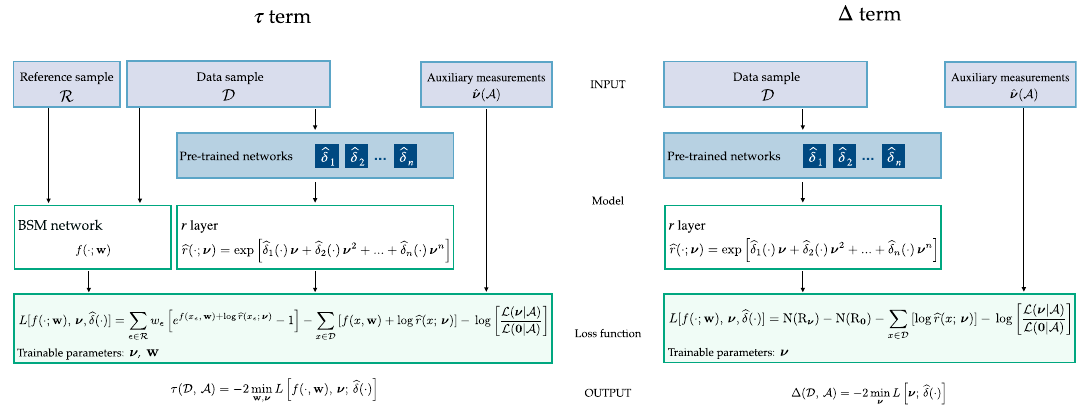
Fig. 4 Schematic representation of the TensorFlow implementation of our algorithm (cid:7) δ As described in Sect. 2.4, computing τ requires the simul- optimized. Indeed, the networks have been trained at a pre- taneous optimization of the parameters w of the neural net- vious stage of the implementation, as described in Sect. work model f ( x ; w ) (dubbed “BSM network” in the figure) and of the nuisance parameters ν . The loss function is the one of Eq. (25). It depends on ν through the distribution ratio r , or more precisely through its estimate (cid:7) r ( x ; ν ) as in Eq. (16). The estimated (cid:7) r ratio is implemented as a TensorFlow “ λ -layer” (denoted as “ r layer” in the figure) that takes as input the (cid:7) δ output of the networks and builds the required polynomial (cid:7) δ function of ν . Notice that the parameters of the networks are “fixed” parameters during training, namely they are not